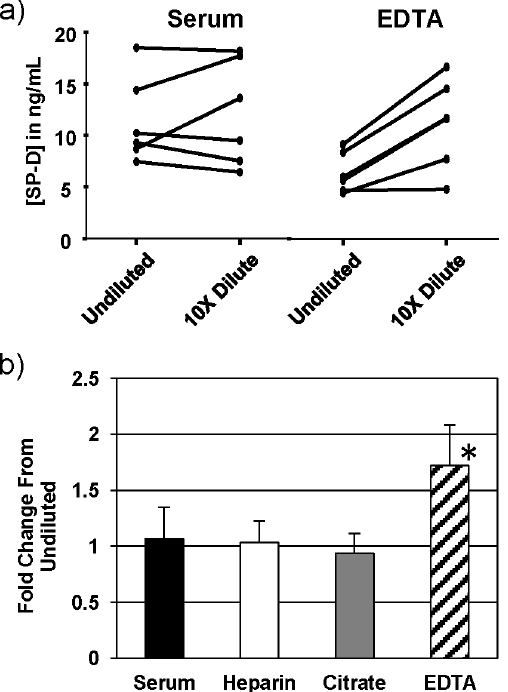
Figure 6. Comparison of SP-D values using neat and diluted samples. a) Serum and plasma samples were assayed as both undiluted and diluted tenfold in PBS. The extrapolated value in the tenfold diluted sample was multiplied by 10 in order to compare to the original, undiluted sample. b) Measured values of diluted samples were normalized to the SP-D concentration in the corresponding undiluted sample in order to compare the effect of the anticoagulant on the measured SP-D concentrations in these conditions. An asterisk (*) denotes p=0.0313 by Wilcoxon signed rank test.